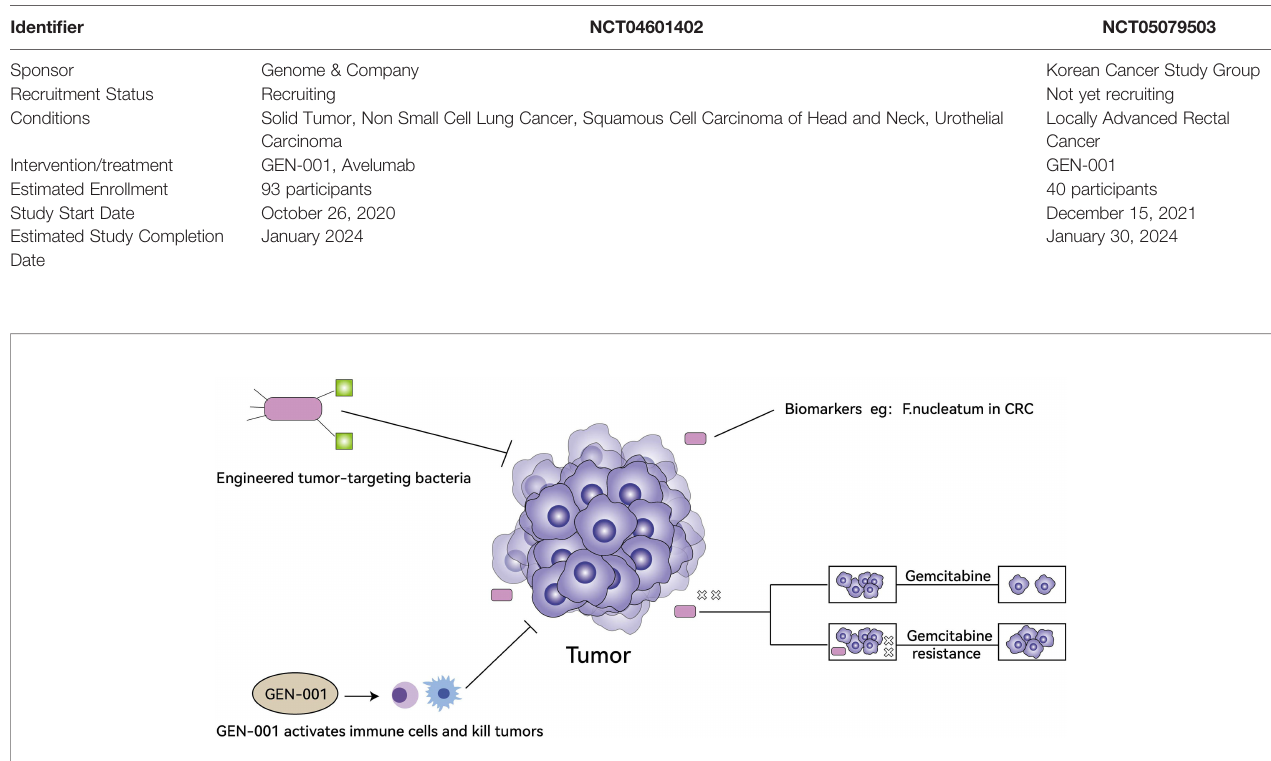
FIGURE 2 | The role of TM in tumor treatment. Engineered tumor-targeting bacteria can kill tumors directly (top left), some bacteria can be used as biomarkers for treatments (top right), oral microbial antitumor agents (GEN-001) activates immune cells to synergistically kill tumors and has begun clinical trials (bottom left), TM can produce small molecules and metabolites (e.g. CDDL) to enhance tumor cell resistance to gemcitabine (bottom